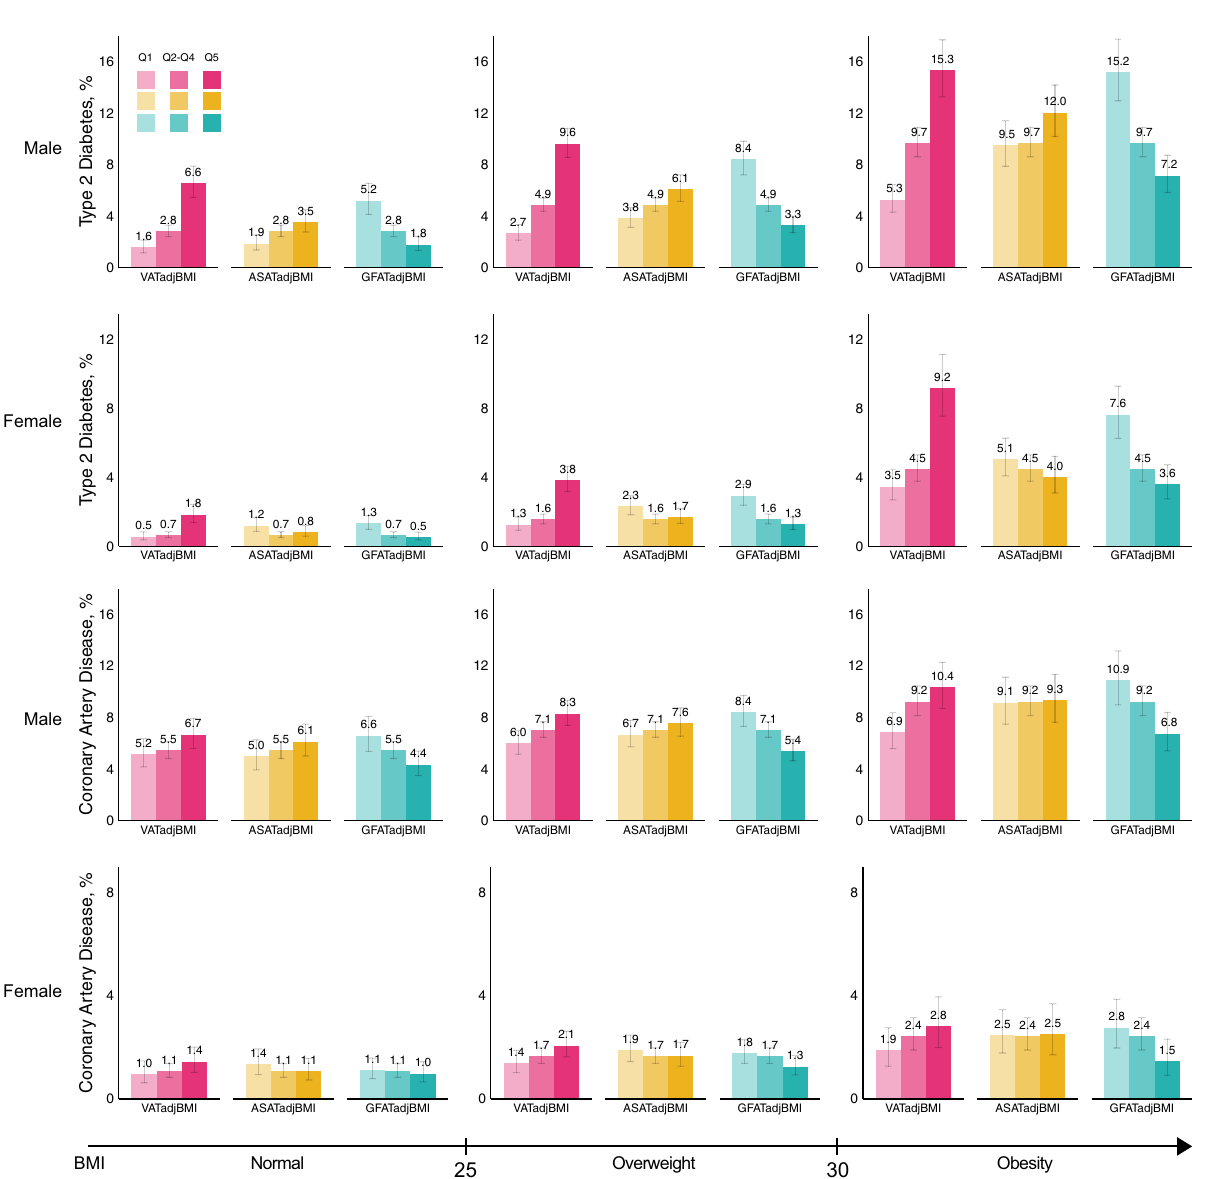
three bars from lightest to darkest represent the bottom quintile, quintiles 2 – 4, and the top quintile of the BMI-adjusted fat depot in question, respectively. Median body-mass index was 25.9kg/m 2 with 15,446 (39.9%) individuals with BMI<25, 16,179 (41.8%) with 25 ≤ BMI<30, and 7055 (18.2%) with BMI ≥ 30. Source data are provided as a Source Data fi le. Abbreviations: BMI, body mass index; VATadjBMI, visceral adipose tissue adjusted for BMI; ASATadjBMI, abdominal subcutaneous adipose tissue adjusted for BMI; GFATadjBMI, gluteofemoral adipose tissue adjusted for